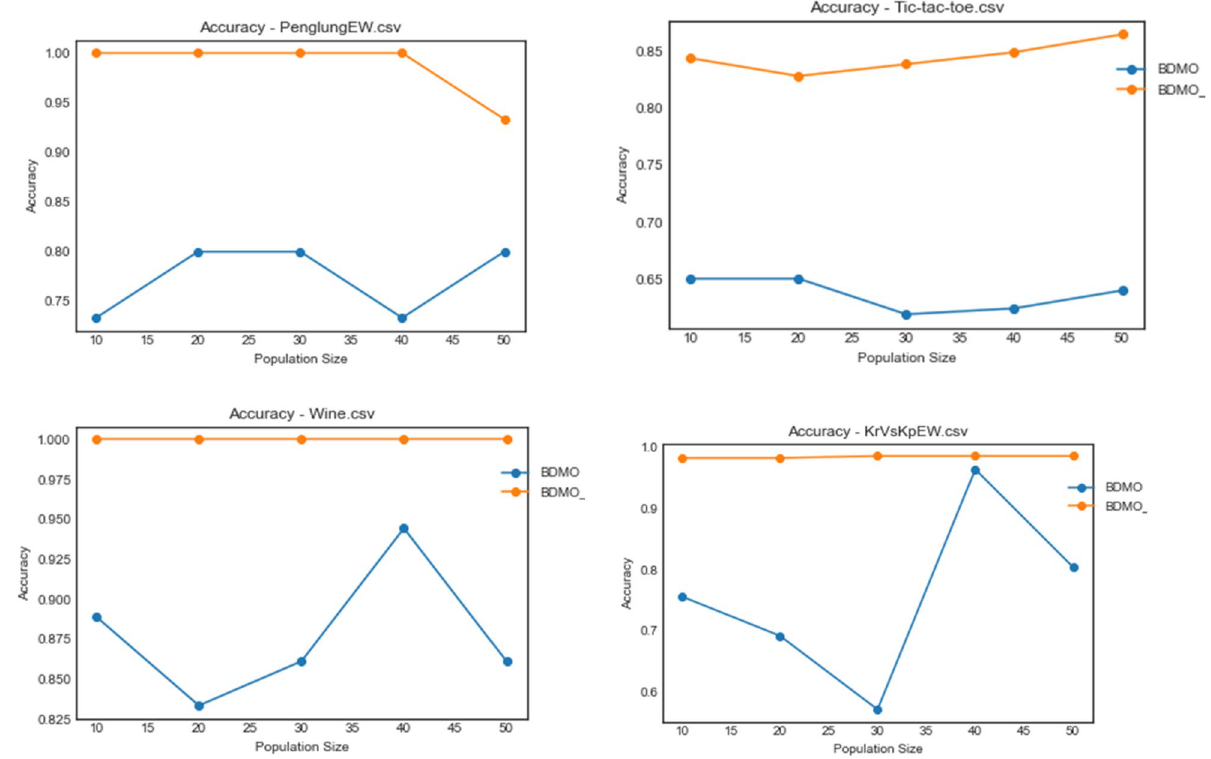
Figure 9. Accuracy plot of the BDMSAO and BDMO on PenglungEW, Tic-tac-toe, Wine, and KrVsKpEW datasets.